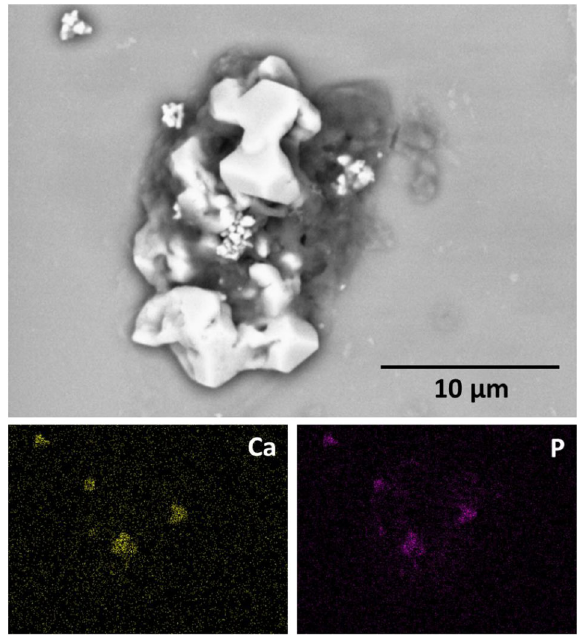
Fig. 10 a SEM image (main image) along with additional SEM-EDX information from quartz substrate for single U-2 OS cell derived from TI-HA- ANN after 21 days in culture under standard conditions, b zoomed-in SEM image from ( a ) and ( c ) point spectra corresponding to red dot within ( b ). Scale bar represents 10 µm